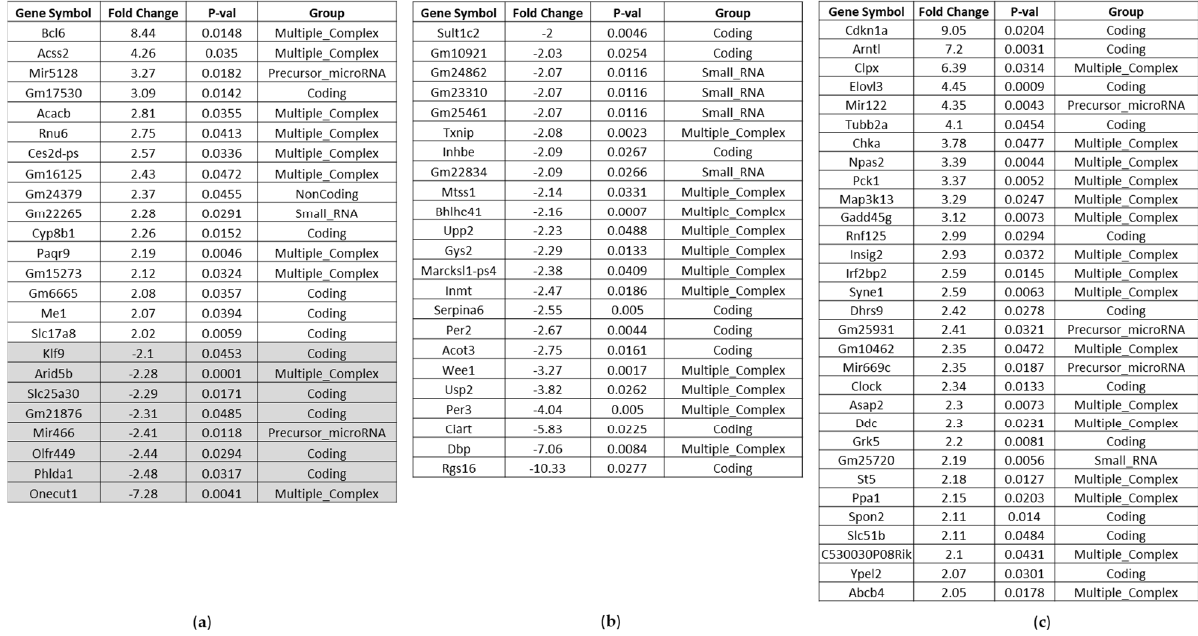
Figure 4. Affected genes in the liver of BC- vs. control-fed mice. ( a ) Significantly up-regulated and down-regulated genes (highlighted in grey) after 2 days BC-fed mice compared to control-fed mice (up-regulated > 2.0; down-regulated < − 2.0). ( b ) Significantly down-regulated genes after 8 days BC-fed mice compared to control-fed mice (down-regulated < − 2.0). ( c ) Significantly up-regulated genes after 8 days BC-fed mice compared to control-fed mice (up-regulated > 2.0). Noncoding RNAs and pseudogenes are not included.